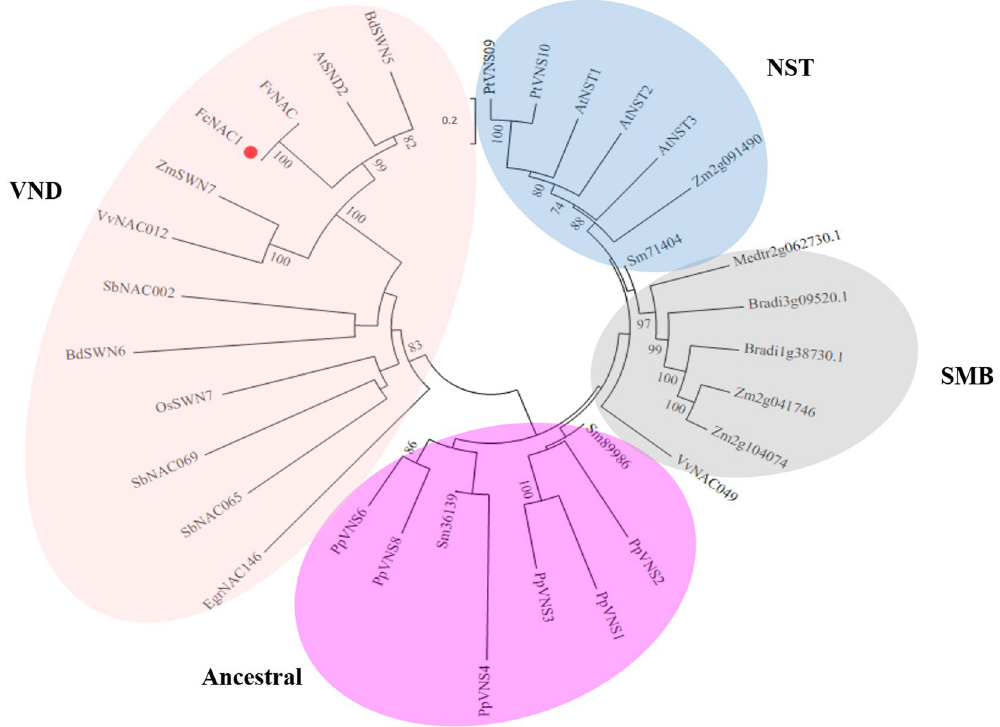
Figure 2. Phylogenetic analysis of FcNAC1 with VNS ( V ND, N ST and S MB) proteins as Master Regulators of cell wall formation. In the analysis, members of the NAC family with function related to cell wall remodeling were included. Representative genes of NST, SMB, VND and ancestral groups were considered for the analysis 32 . The phylogenetic tree was performed with MEGA5 software employing the neighbor joining method, with 1000